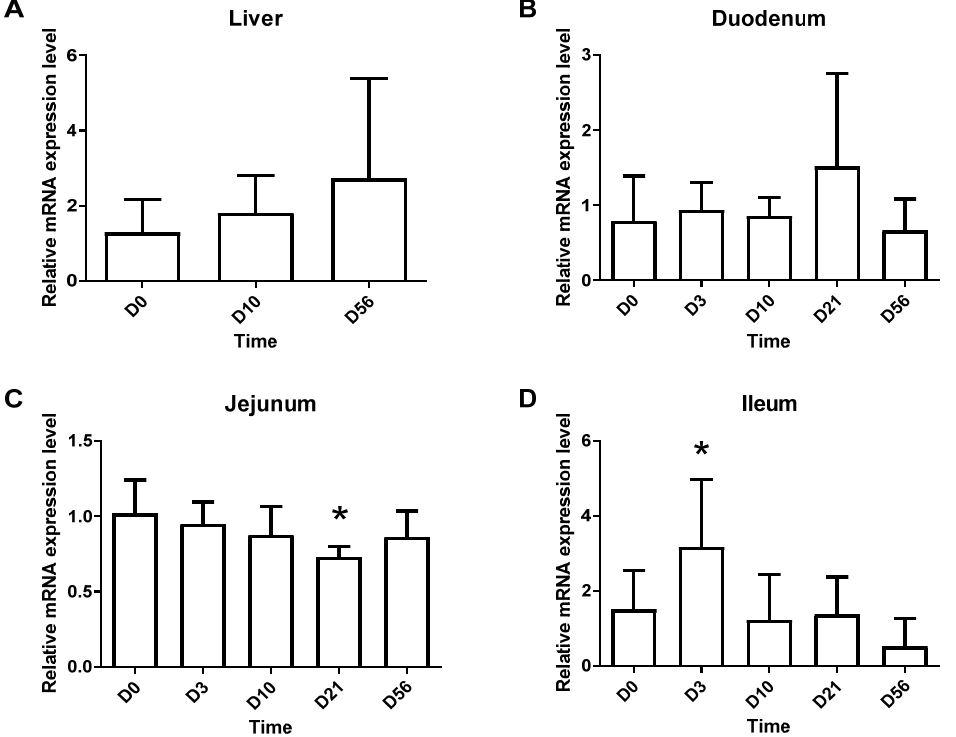
Figure 6. Leap2 mRNA expression in the liver and small intestine following the initiation of an HFHS diet. Gene expression of Leap2 in the liver ( A ), duodenum ( B ), jejunum ( C ), and ileum ( D ) at different HFHS diet time points as measured by qPCR. Relative mRNA expression relative to mice at day 0 is represented as mean ± S.D.). n = 10–12. * p ≤ 0.05.